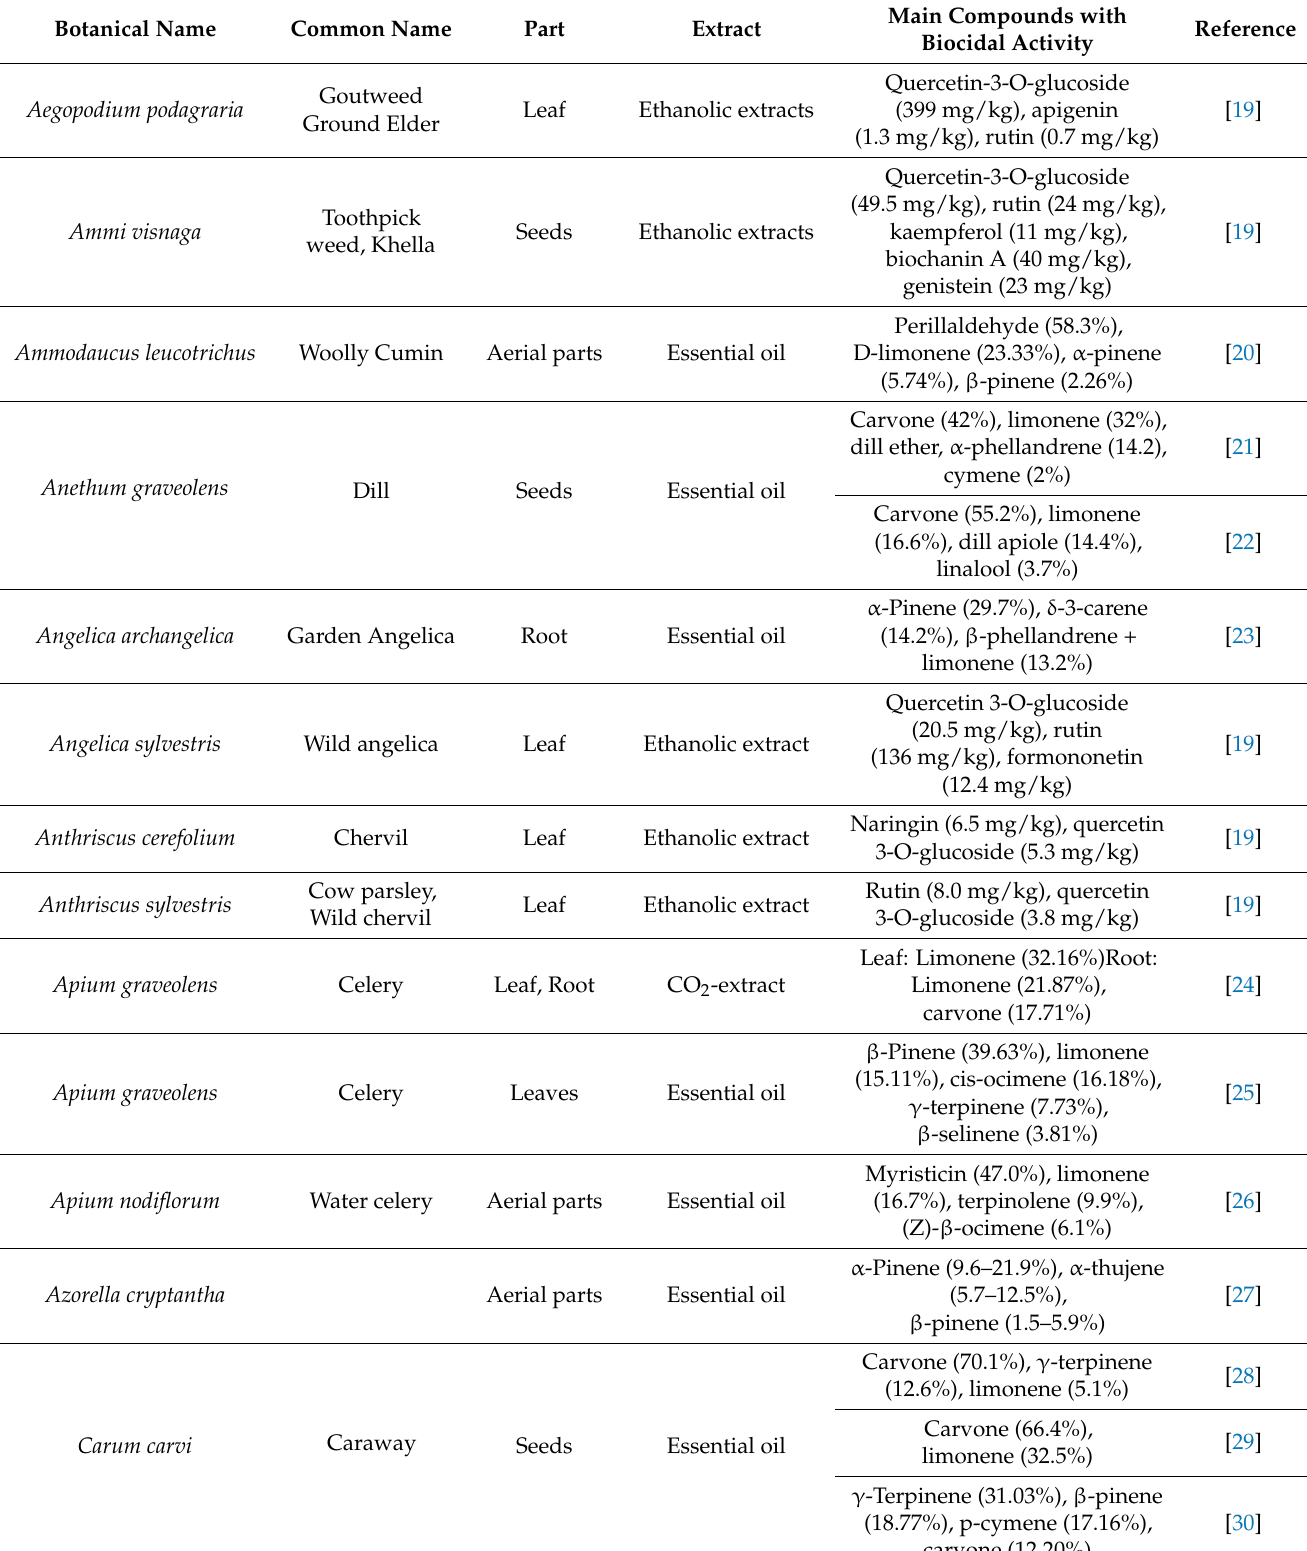
Table 1. Phytochemicals in Apiaceae plant